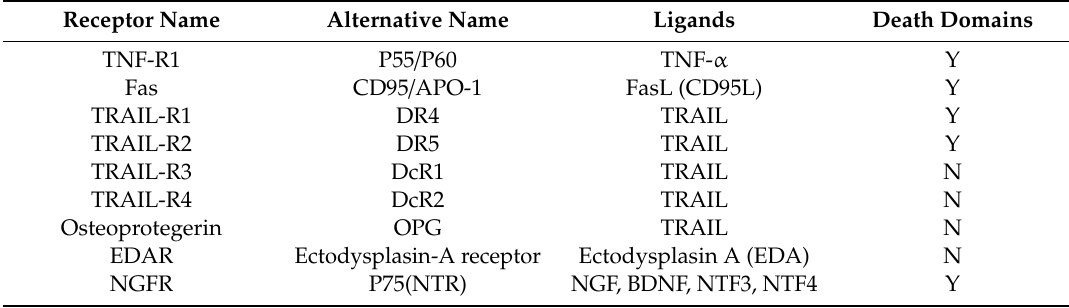
Table 1. Death receptors and